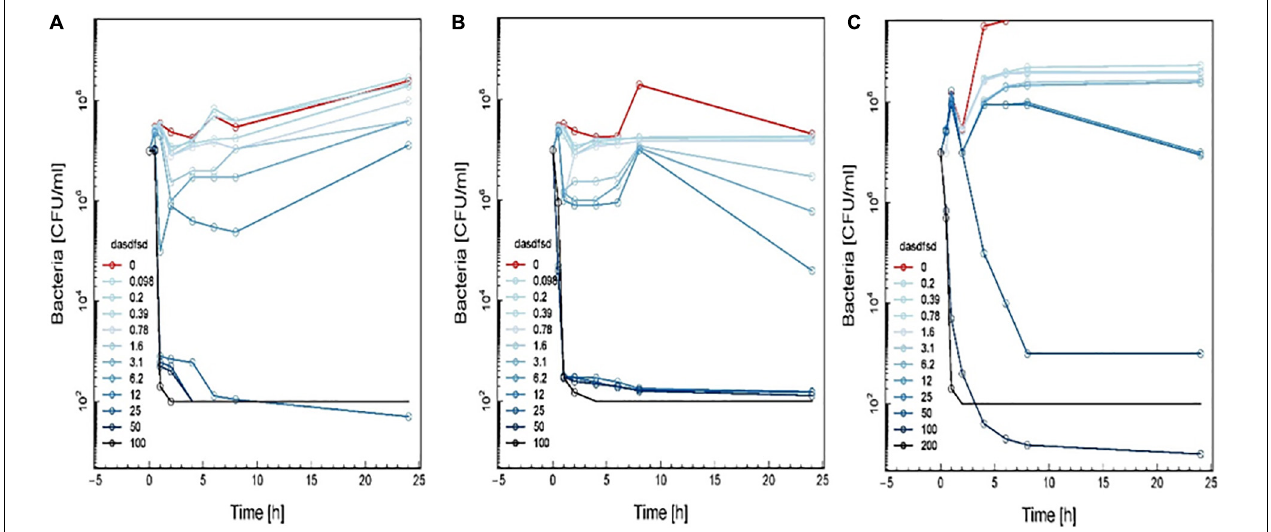
FIGURE 7 | Time-kill curve study of 2a (A) , 1a (B) , and 1b (C) versus MRSA in log-phase at drug exposure. The curve displays the mean CFU for duplicate samples and represents data from two independent experiments. Twelve doubling dilutions are plotted, the highest concentration ( black line ) corresponds to 16 × MIC. Growth in absence of antimicrobial is drawn in red . The compound was added at time point 0 and monitored until 24 h. The limit of detection in the assay was 100 CFU mL − 1 .